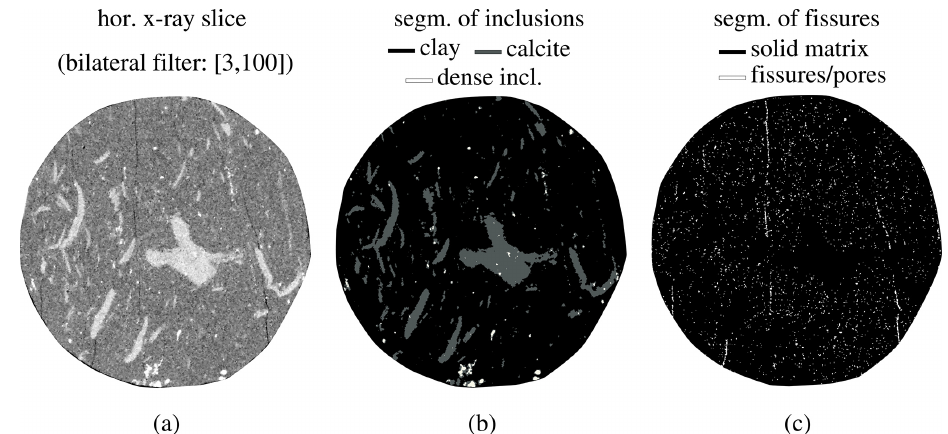
Figure B1. Horizontal slices after the (a) application of a bilateral filter, (b) segmentation of the two types of inclusions (calcite and denser inclusions) and (c) micro-fissures.